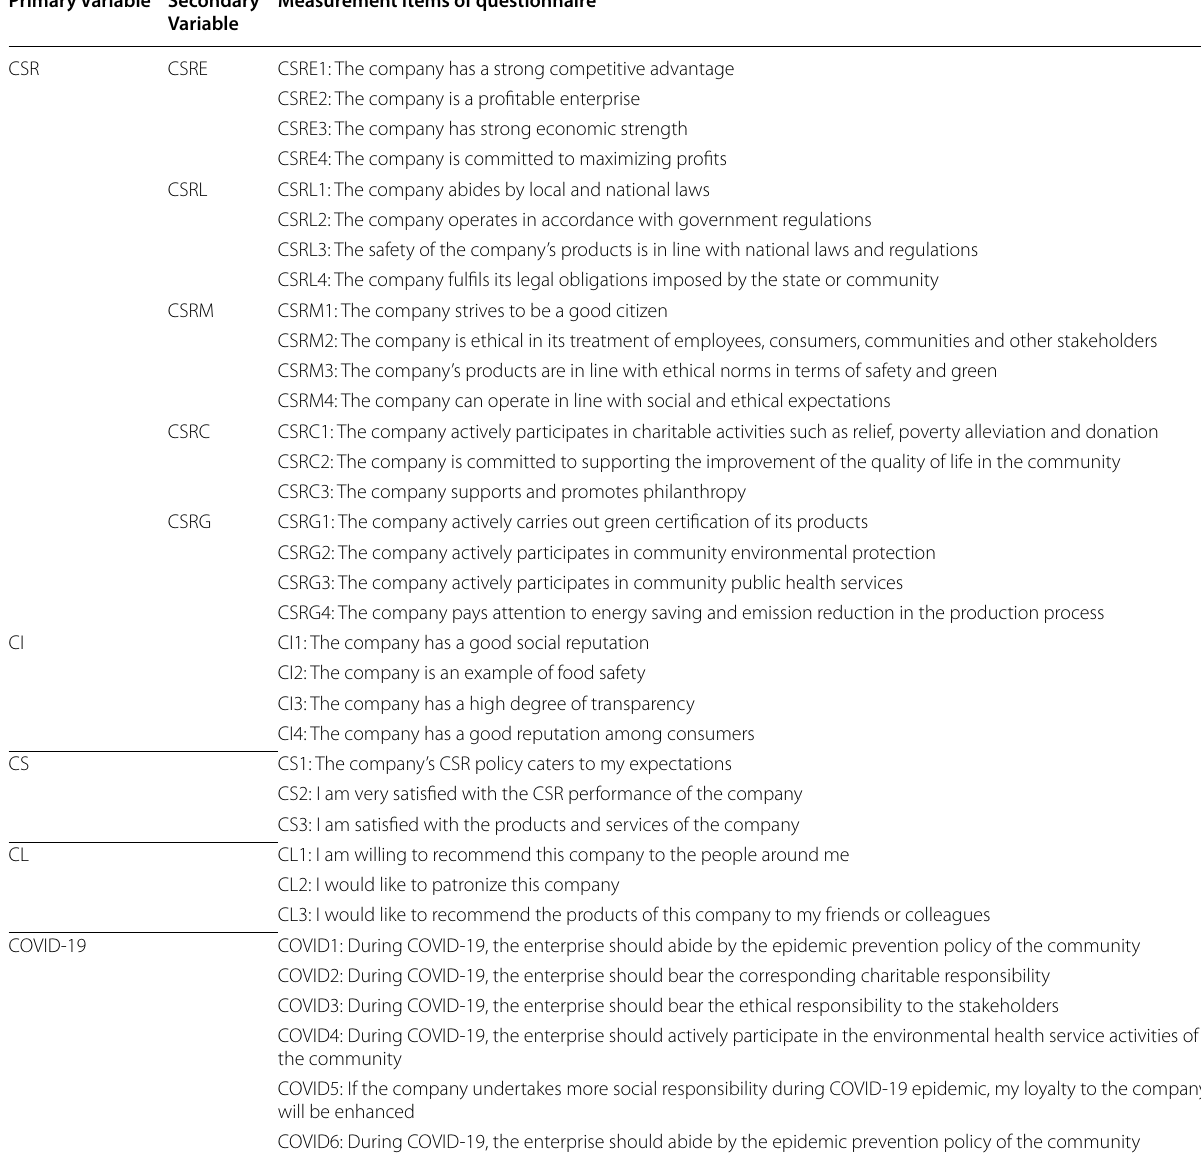
Primary Variable Secondary Measurement Items of Variable